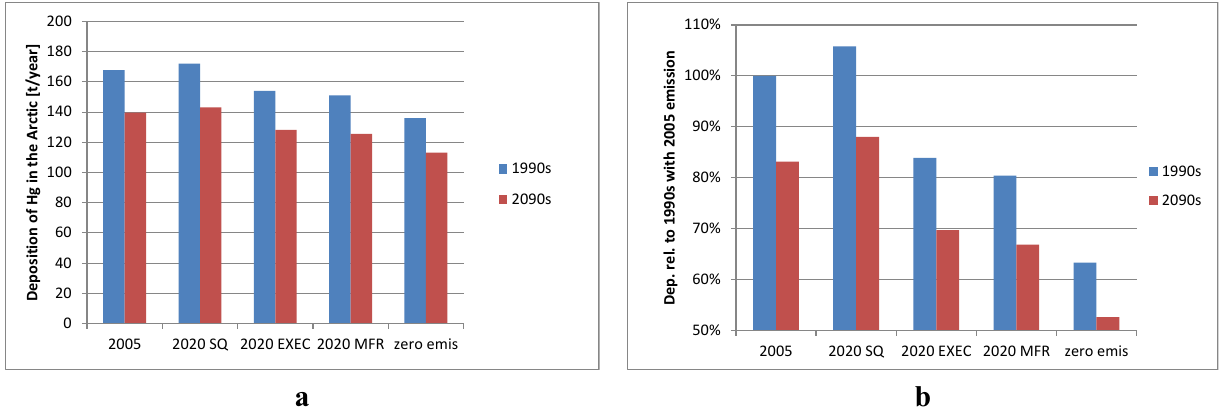
Figure 7. Total mercury deposition in Tons Hg/year to the Arctic for all different emissions scenarios from DEHM ( a ) and the relative difference in % ( b ) for the 1990s (blue) and the 2090s (red).